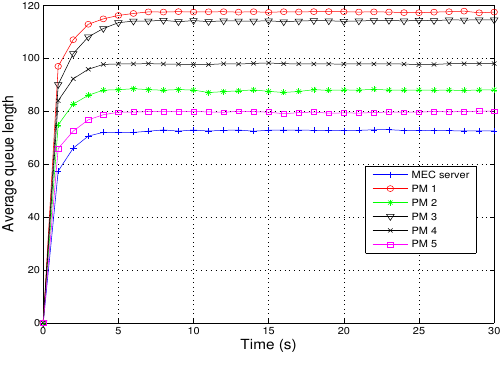
Figure 4. Average queue length vs.